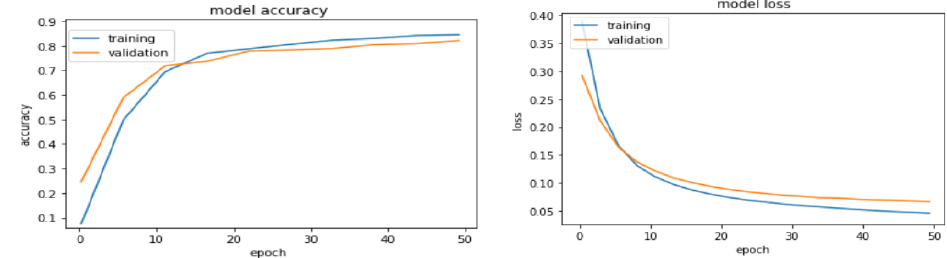
Figure 18. Model accuracy and loss plots for the VIRAT Video dataset.